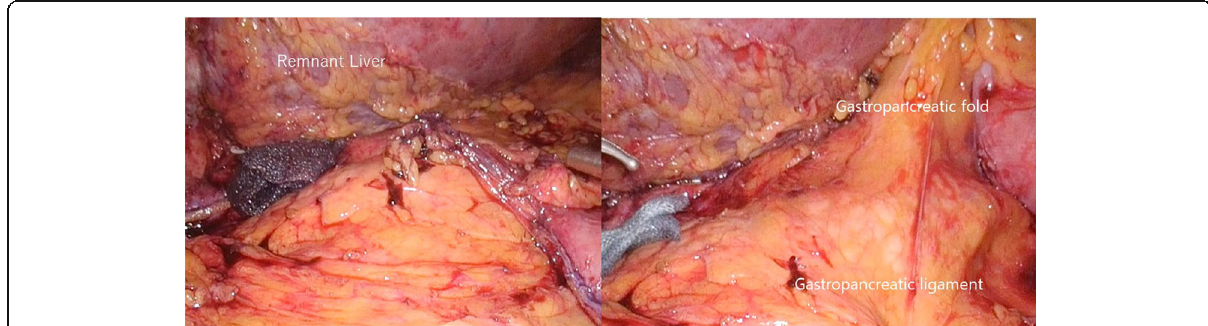
Fig. 6 Adjusting the traction on the gastropancreatic ligament was necessary for managing a limited surgical field by the enlarged remnant